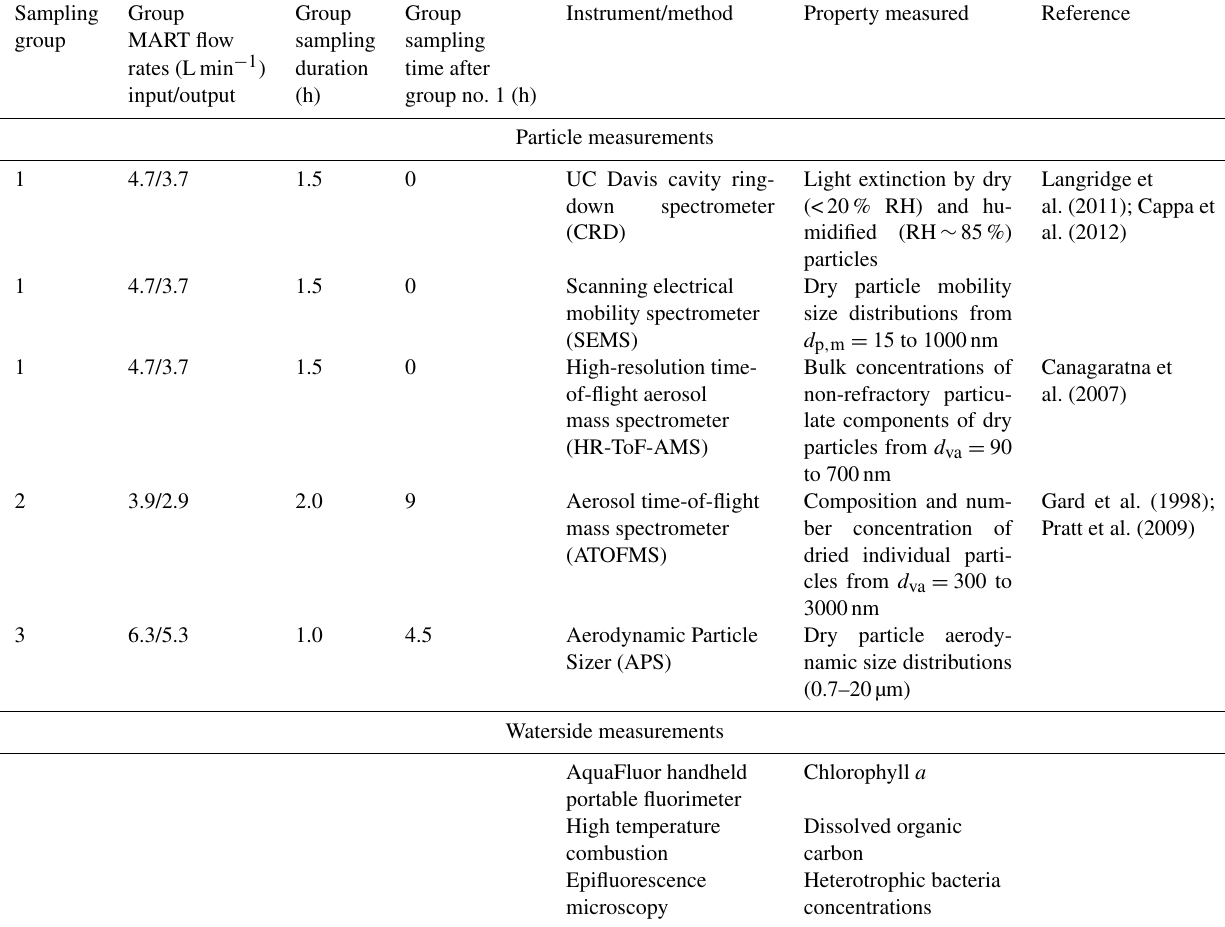
Table 1. Summary of all instrumentation used in this study. Sampling Group Group Group Instrument/method Property measured